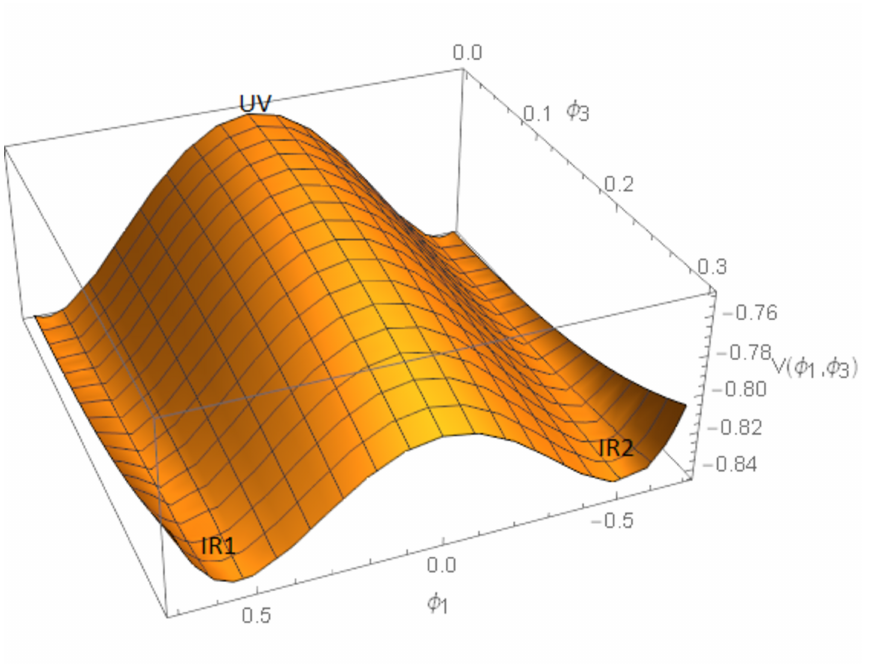
Figure 5. Image of the potential, V with φ = φ 2 = 0 . 4 3 g 2 = − 2 . Comparing (4.3) with V sad 3